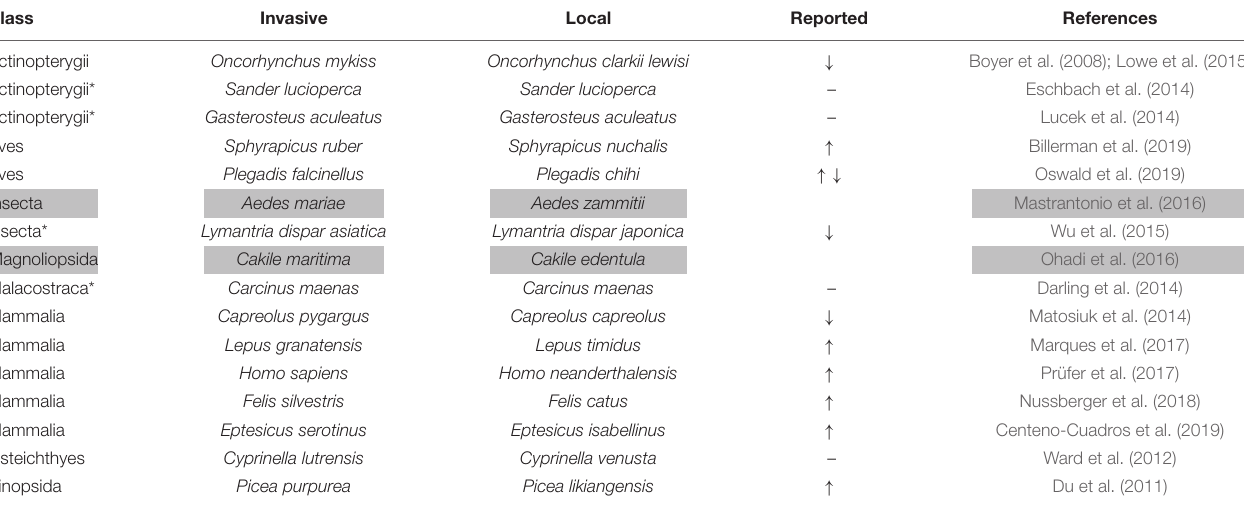
TABLE 2 | Examples of spatial gradients of introgression or admixture after range expansion of biological